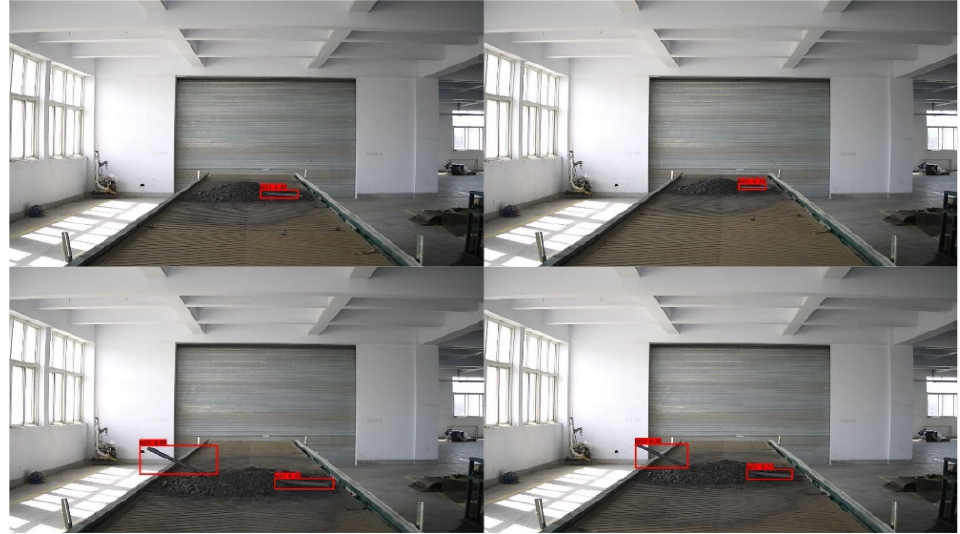
Figure 25. Semi-buried bolt detection.